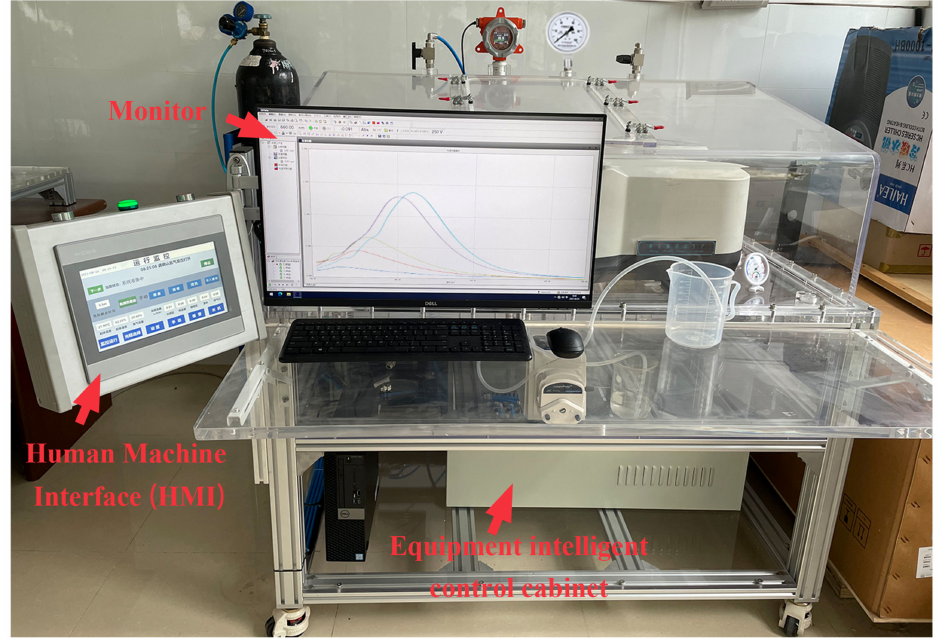
Figure 3. Spectrophotometric system nitrogen protection automation device physical